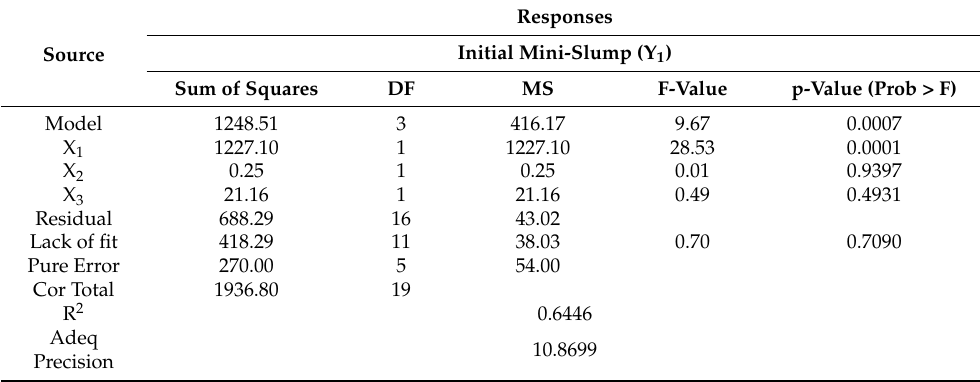
Table 5. Analysis of variance (ANOVA) of the response model of initial mini-slump.